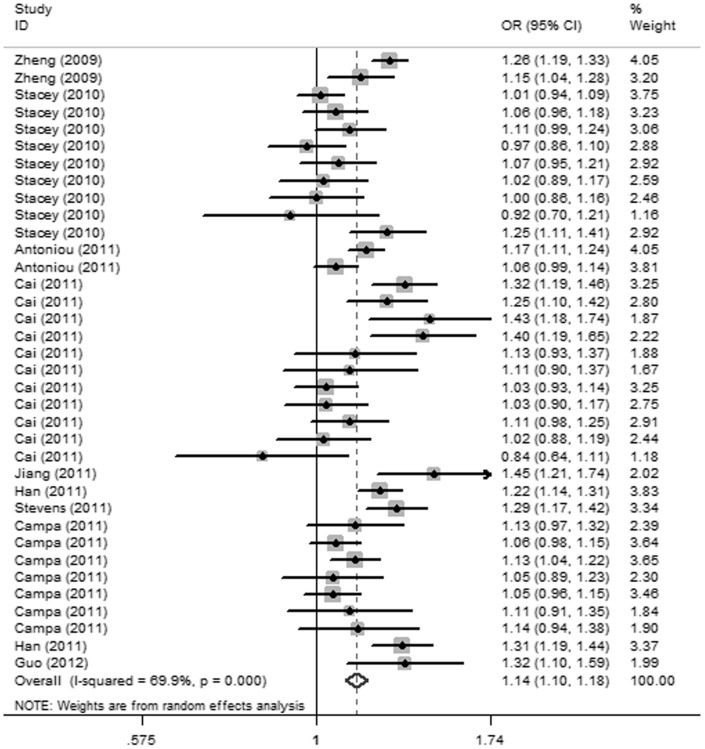
Forest plot of association between rs2046210 and BC risk under allelic model.